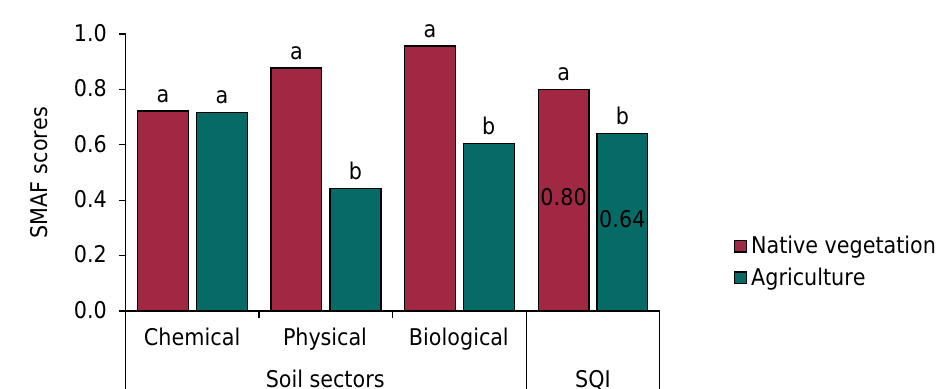
Figure 2. Soil sectors (chemical, physical, and biological) (a) and overall Soil Quality Index (SQI) (B) for the 0.00-0.20 m layer in a native vegetation and long-term cropped area (agriculture). Mean scores within each sector or SQI followed by the same letter do not differ among themselves according to Tukey’s test